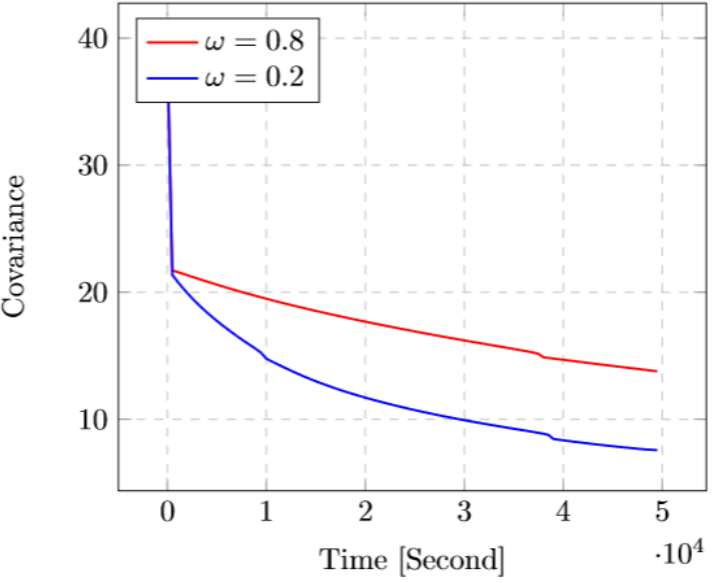
Figure A1. Covariance for an alternative environment, namely with ω = 0.8 and ω = 0.2 and 10 sensors.